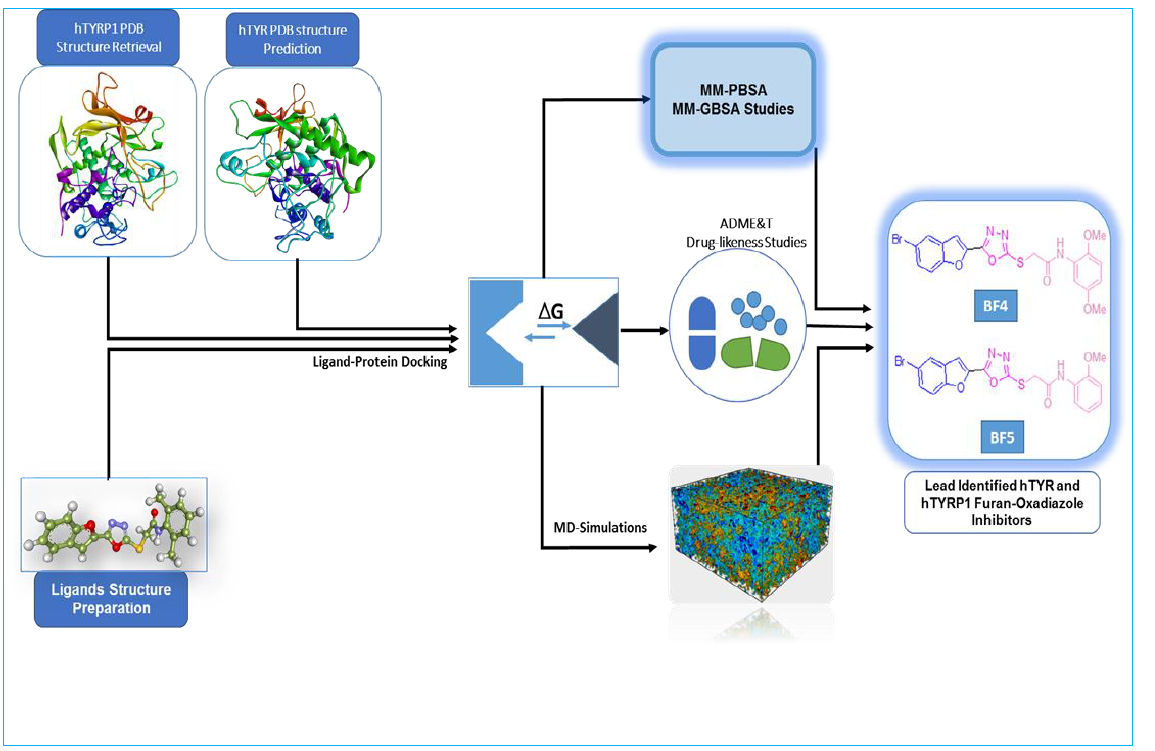
Figure 3. In silico work flow for discovery of novel hTYR and hTYRP1 inhibitors via CADD.